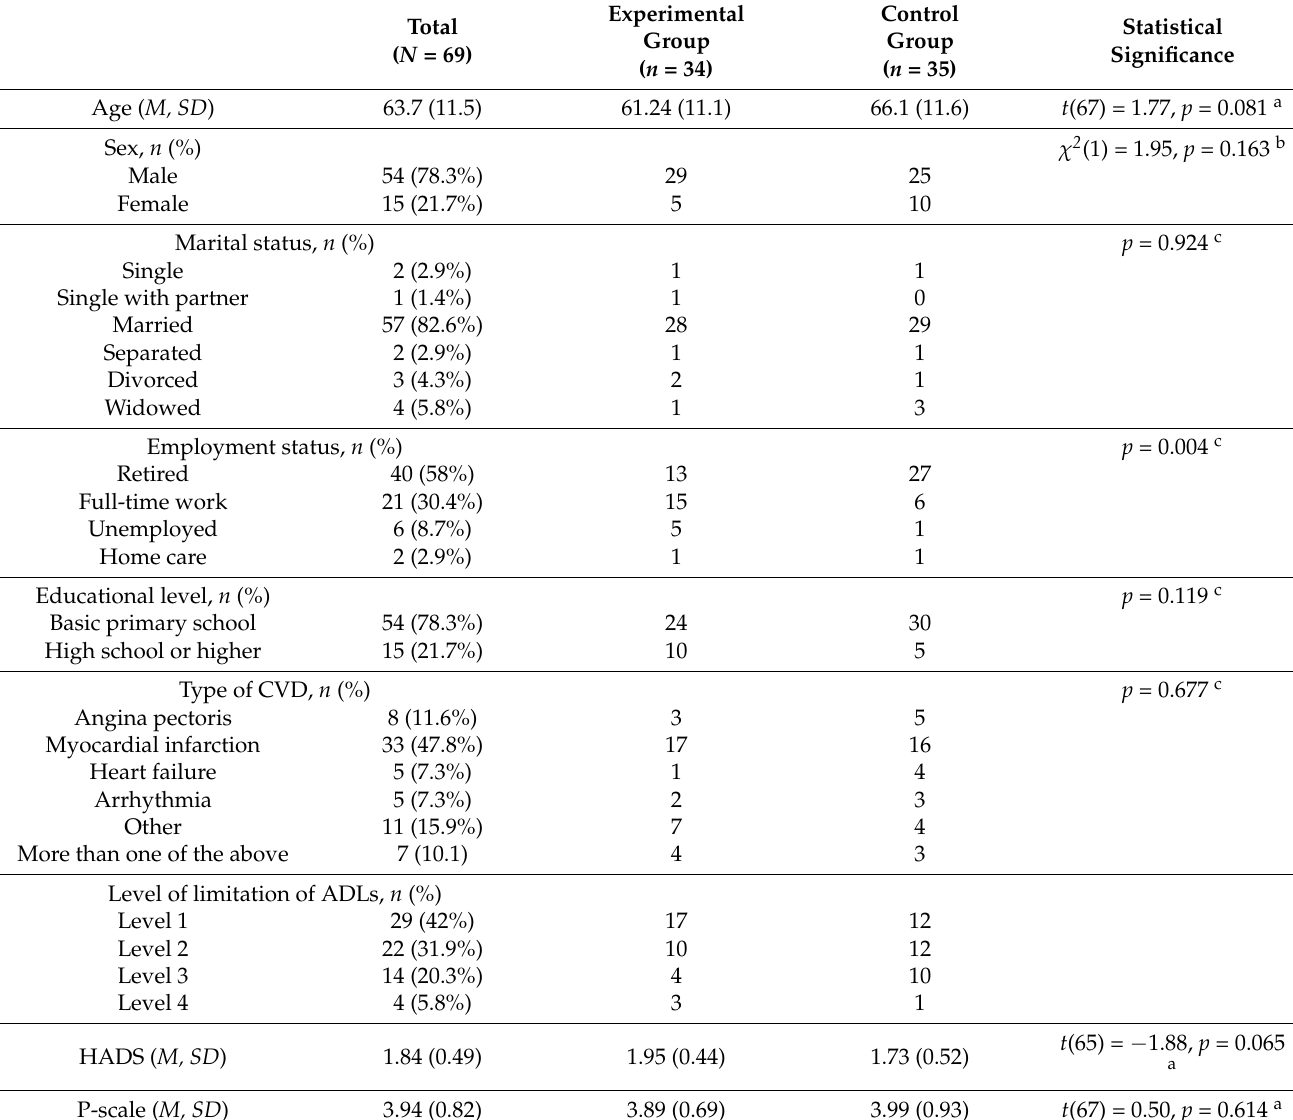
Table 1. Participant sociodemographic and clinical characteristics of the study sample.